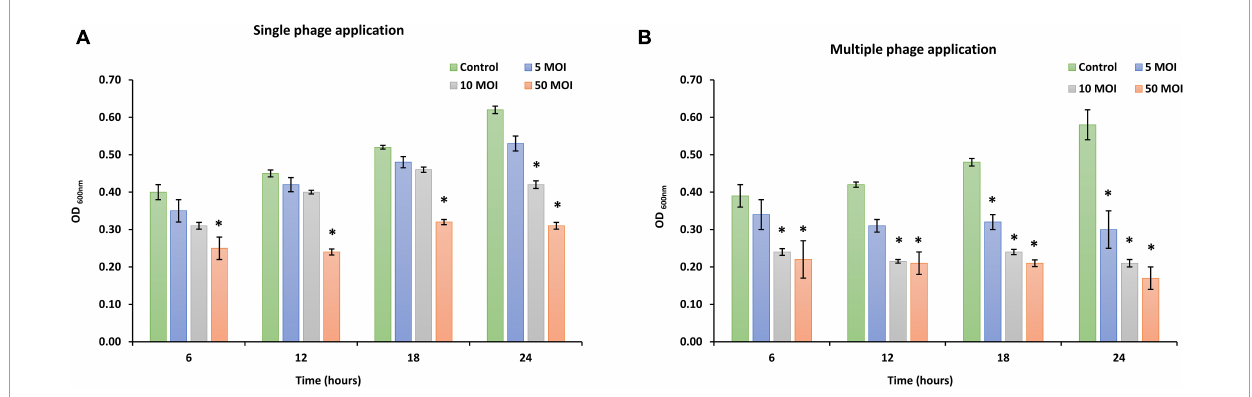
FIGURE7 In vitro virulence of phage LPSent1 on biofilms of S . Enteritidis EG.SmE1 at different MOIs. (A) A single treatment with phage LPSent1. (B) Multiple treatments with phage LPSent1. Phage LPSent1 was applied at three different MOIs (5, 10, 50) while untreated cells were used as a negative control. Values represent the mean ( n = 3) with a standard deviation of three determinations of each point and were analyzed by Student’s t -test; ∗ indicates significantly different from the corresponding control, p ≤ 0.05.